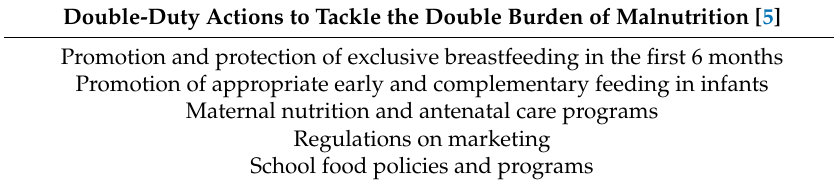
Table 1. The World Health Organization’s recommended double-duty actions to tackle the double burden of